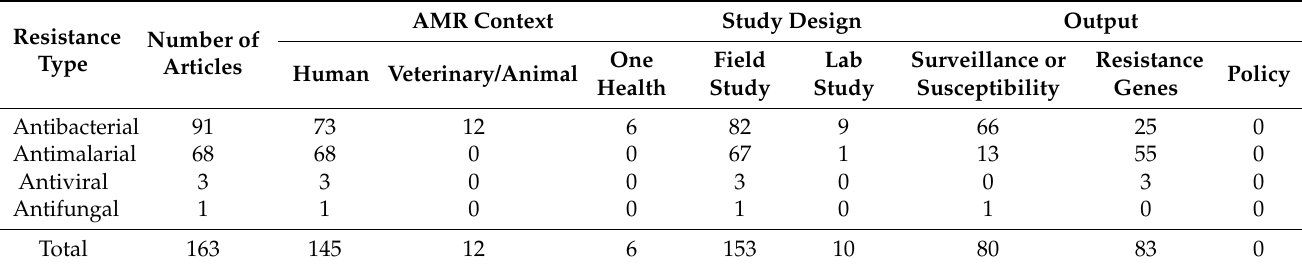
Table 1. Summary of characteristics identified across included